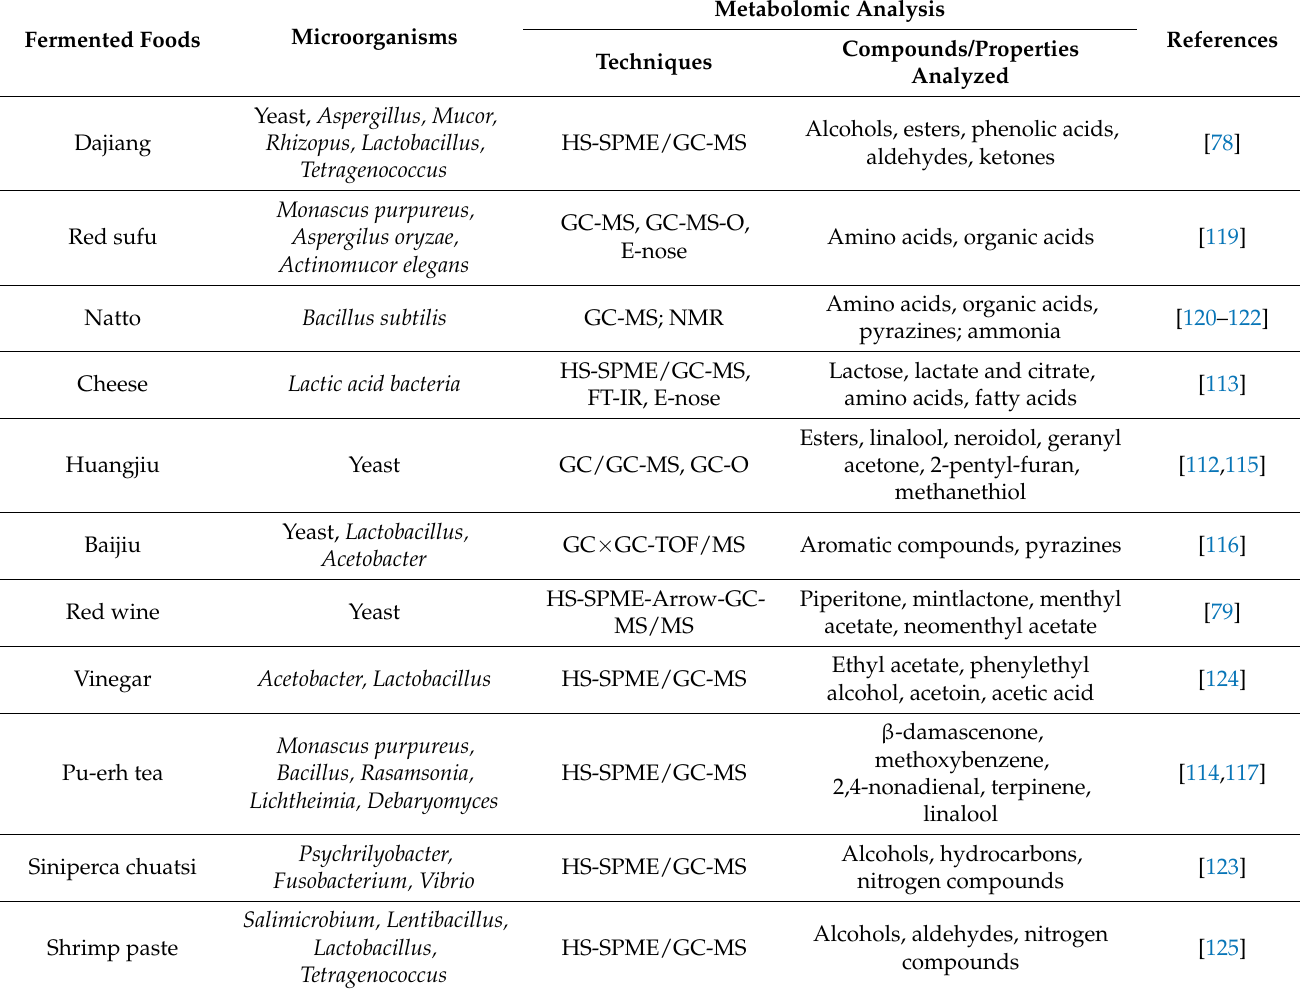
Table 2. Metabolomics applied to different fermented foods on the flavor